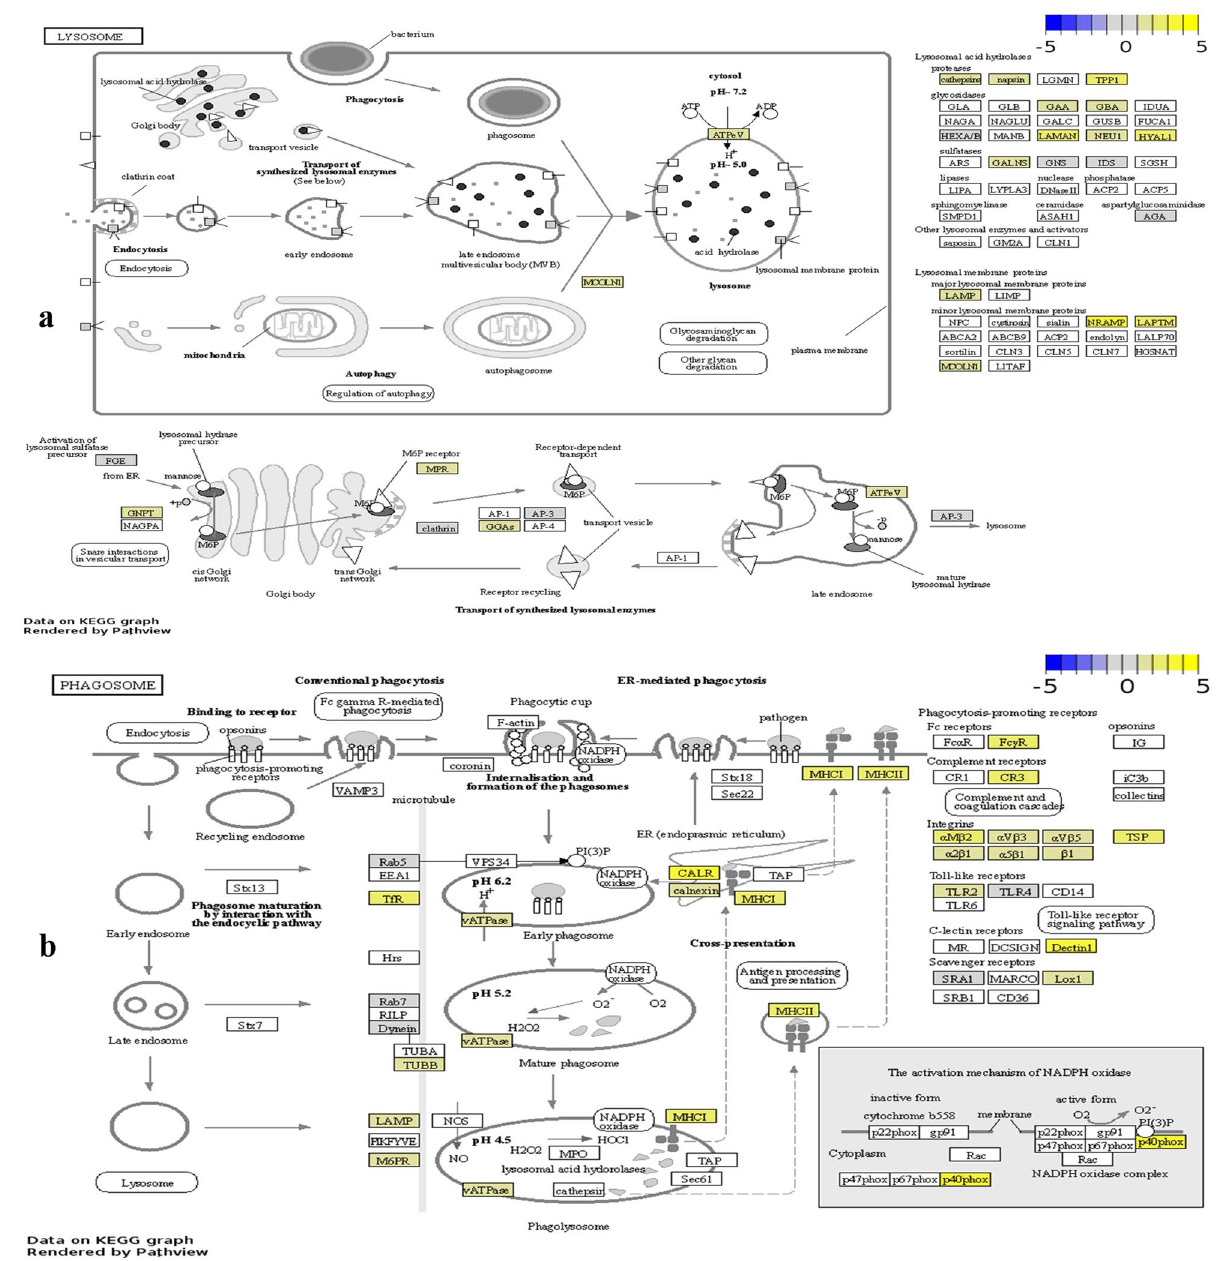
Figure 6. Upregulated genes enriching the ( a ) Lysosome (fca04142), and ( b ) Phagosome (fca04145) pathways in LB f HER2- tumours. Gene log 2 fold change relative to controls is indicated in yellow (upregulated) or blue (downregulated), white boxes represent genes not detected. Data on KEGG graph rendered by “Pathview” (https:// pathv iew. uncc. f HER2− tumours, and represented a combination of approximately half up- and downregulated DEGs in TN tumours (Tables S6–8). In contrast, DEGs in this pathway were predominantly downregulated (~ 70%) in CLs. (Table S9). Notoriously, recurrently downregulated DEGs in this pathway represented membrane-, and/or extra- cellular matrix-associated components shared between the ECM-receptor interaction and the focal adhesion pathways. Additional cell surface components (e.g. laminins and collagens) were also predominantly downregu- lated in CLs. Similarly, laminins were predominantly downregulated across tumour sample groups among which LAMA2 and LAMA3 were downregulated across all sample groups. On the other hand, collagen molecules were up or downregulated across different tumour subtypes and only COL2A1 was upregulated across all sample groups (Table S10). Additional pathways behind cell adhesion and actin cytoskeleton remodelling were also associated with downregulated DEGs in CLs (e.g. Gap junction, Rap1 signalling, and cell adhesion molecules [CAMs]), as well as, several immune system and endocrine system-related pathways (Table S9). To sum up, cell